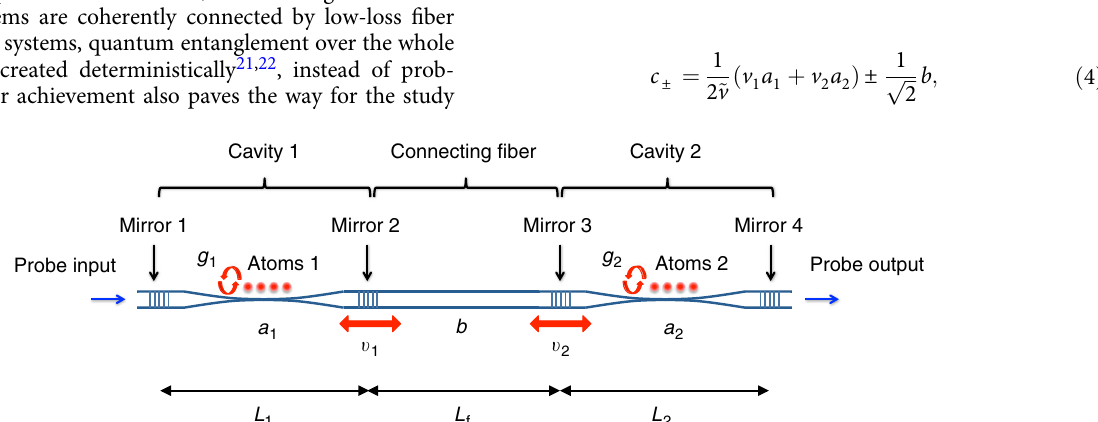
Fig. 1 Schematic of the coupled-cavity QED system. Cavity 1 of length L 1 and cavity 2 of length L 2 are coupled to a connecting fi ber of length L f with coupling rates of v 1 and v 2 , respectively. Atomic ensembles are coupled to Cavities 1 and 2 with atom-cavity coupling rates of g 1 and g 2 , respectively. Probe beam is input from the left mirror of cavity 1 (Mirror 1), and its output from the right mirror of cavity 2 (Mirror 4) is